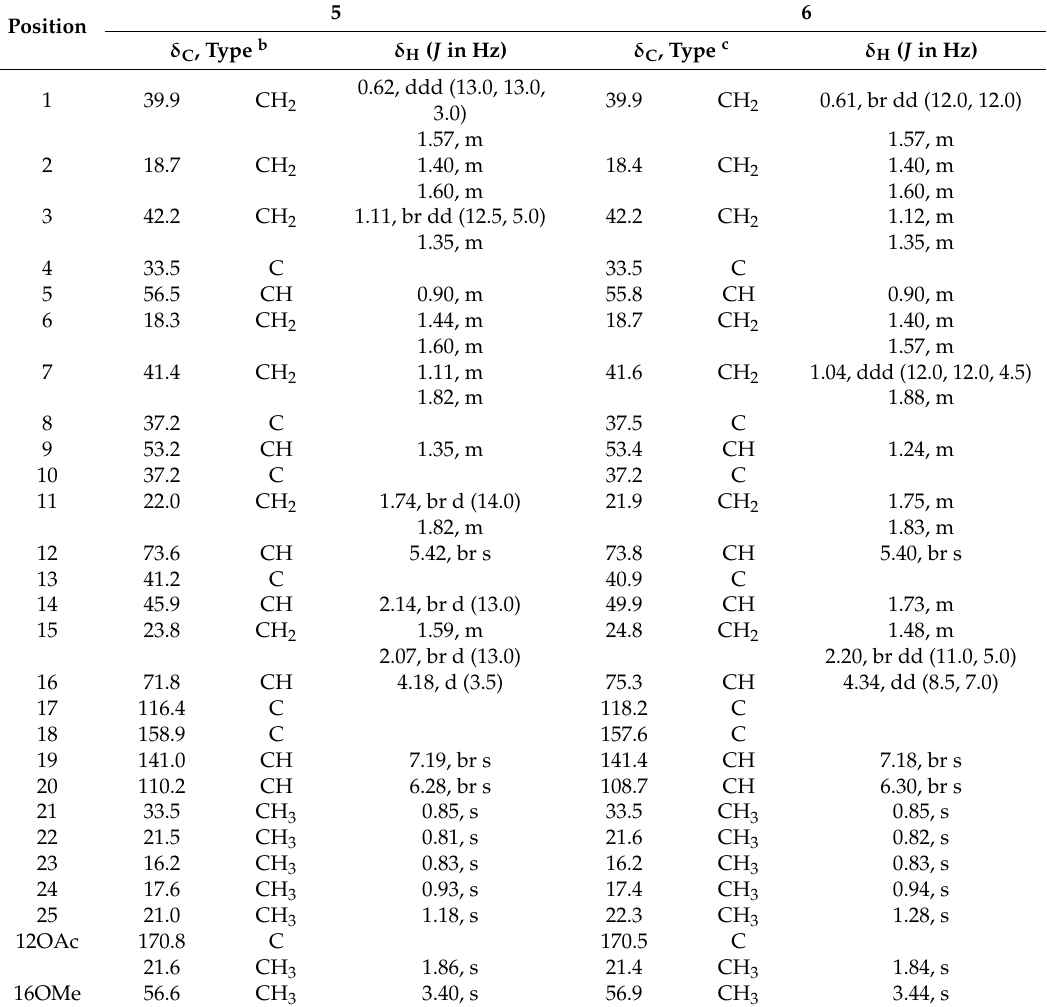
Table 2. 1 H- and 13 C-NMR data (500 and 125 MHz) for compounds 5 and 6 a